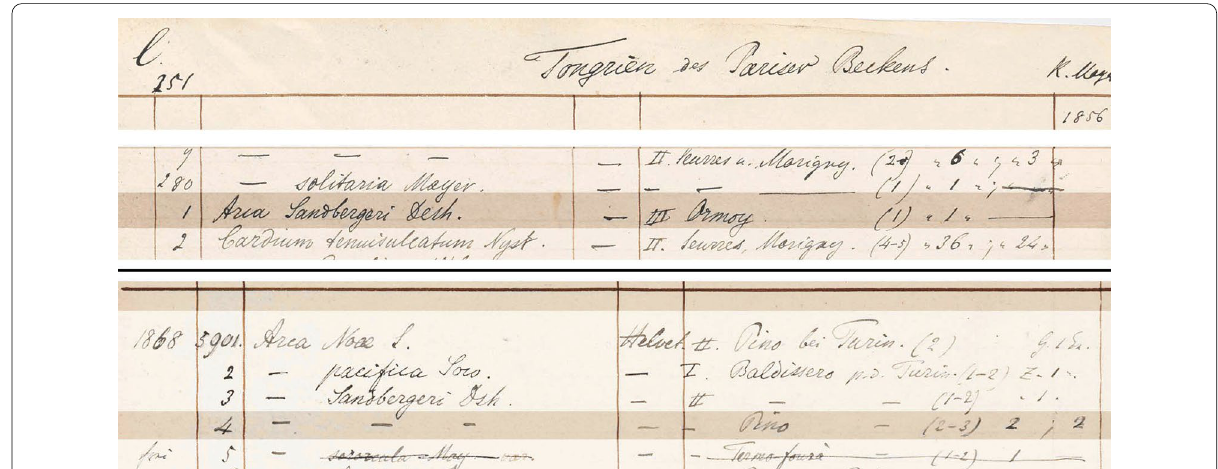
Fig. 11 Two entries for the bivalve Arca sandbergeri Deshayes, 1858, above in the inventory book 005 Zurich 2, and below in the inventory book 001 Po. Compare with the corresponding “old” labels in Fig.